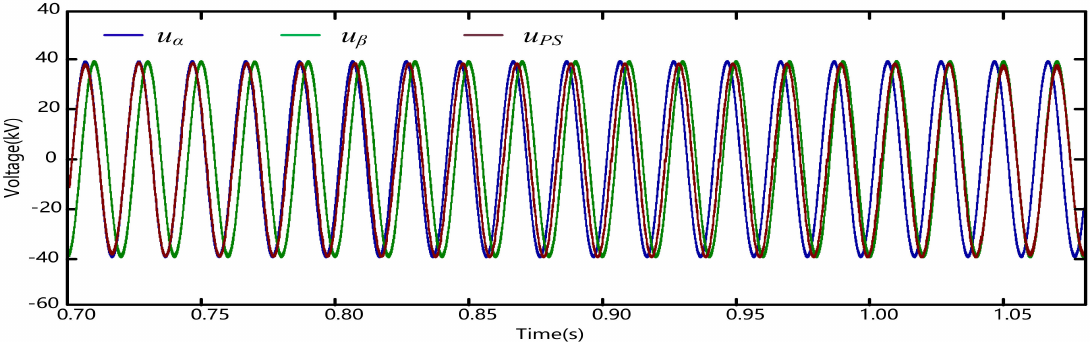
Figure 12. Voltages of upward PS and traction feeders during phase shift